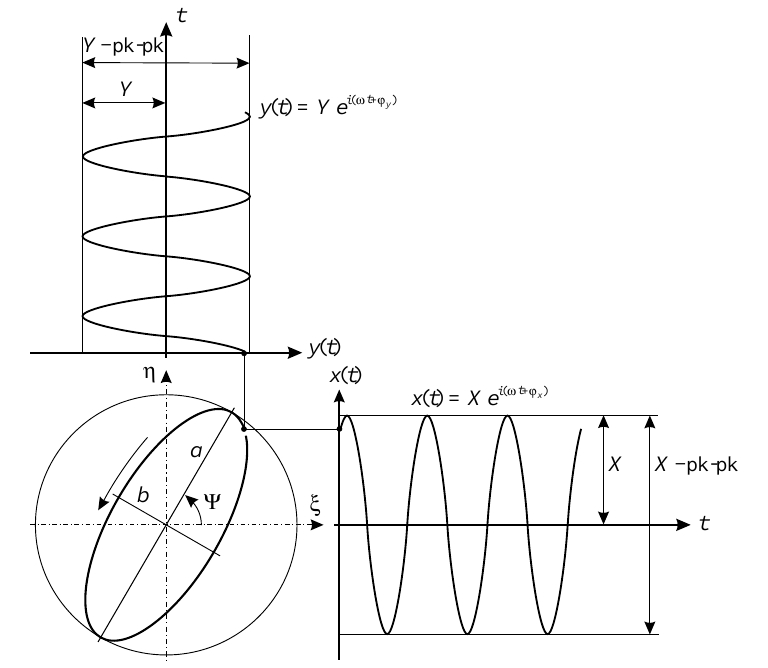
Fig. 1. Filtered orbit and vibration